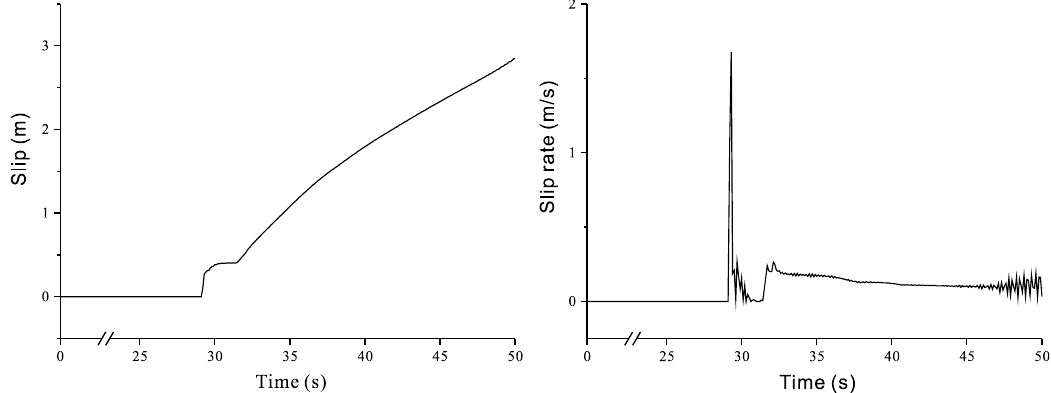
Figure 3. The slip and slip rate of the center point of the barrier on the SW model fault change with time.